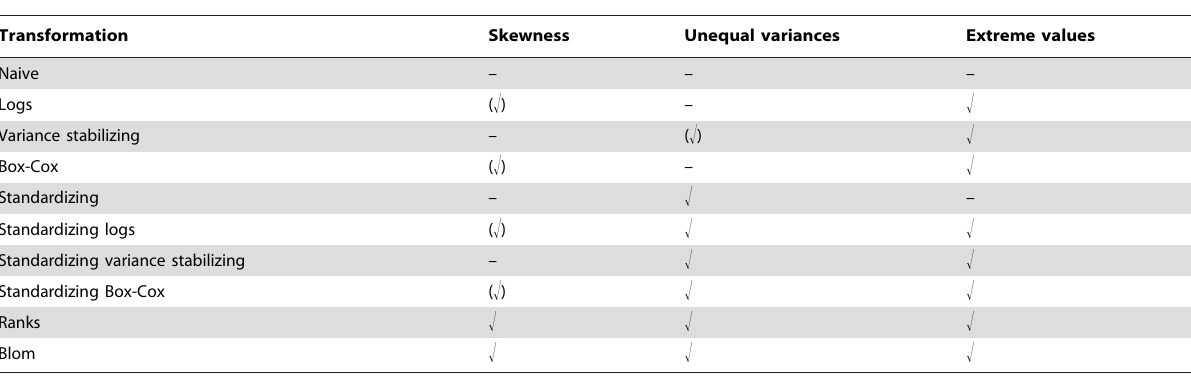
Table 1. Transformations for RNA-Seq